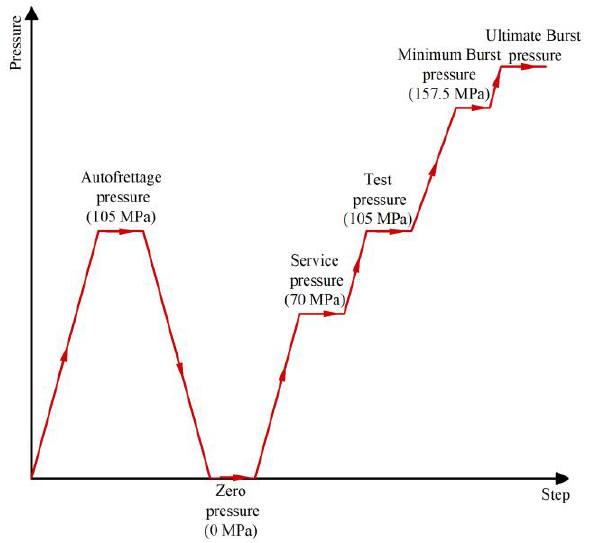
Figure 10. Loading history for FEM of hydrogen storage composite vessels.